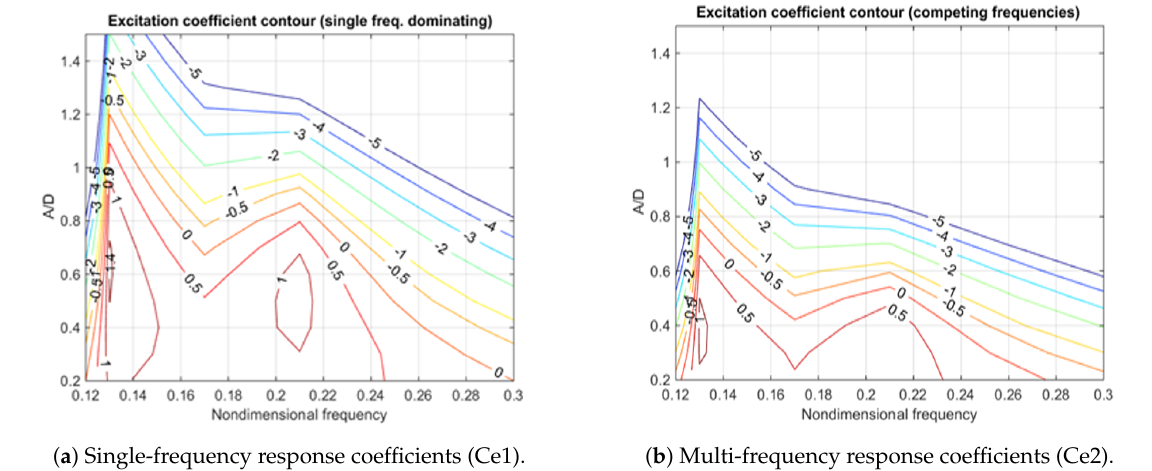
Figure 9. CF excitation coefficient contour plot corresponding to two sets of hydrodynamic